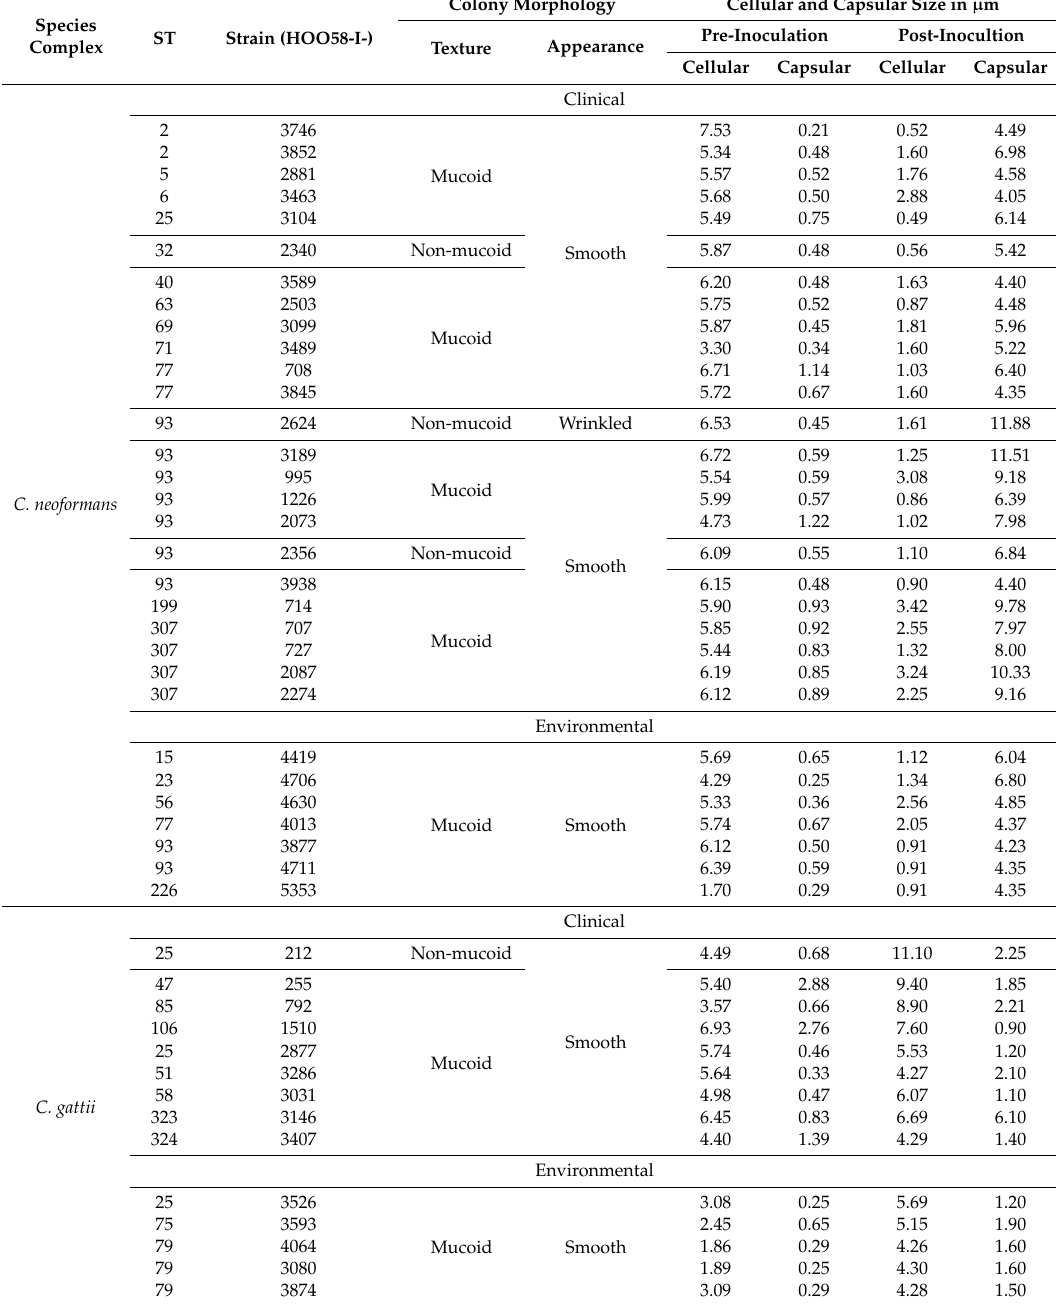
Table 1. Phenotypic assays of C. neoformans and C. gattii clinical and environmental isolates inoculated in the invertebrate virulence model of G. mellonella . Association with sequence type (ST).